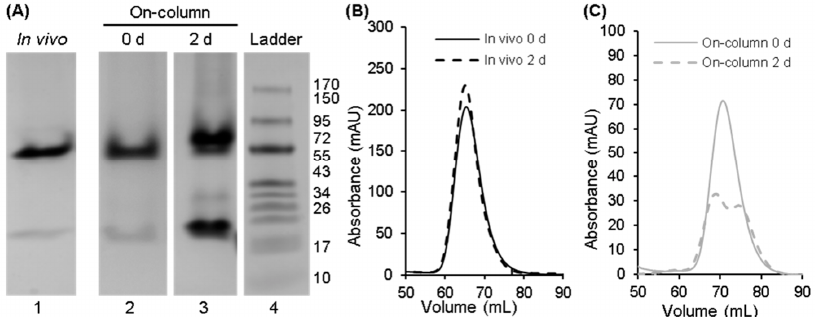
Figure 4. Native PAGE and qualitative SEC analyses to compare the stability of the in vivo-associated and on-column-associated complexes of Scc4:His 6 -Scc1. ( A ) Native PAGE gel of the in vivo-associated complex (lane 1) and the on-column-associated complex after purification (lane 2) and 2 days at room temperature (lane 3). (Native PAGE analysis of the in vivo-associated complex after 2 days at room temperature is shown in Figure 6, lane 2 from a second stability study.) Lane 4 is the Fisher BioReagents EZ-Run Rec pre-stained protein ladder with molecular weights listed to the right in kDa; the ladder was included as a qualitative guide. The full gels from which these lanes were extracted are shown in Figure S4. ( B , C ) Qualitative SEC analysis to assess the stability of ( B ) the in vivo-associated complex after purification (0 d, black solid line) and after 2 days at room temperature (dashed black line) and ( C ) the on-column-associated complex after purification (0 d, gray solid line) and after 2 days at room details). temperature (dashed gray line). Di ff erences in the elution times between the ( B ) in vivo- and ( C ) on-column-associated complexes are not interpretable (refer to Section 2.5 for